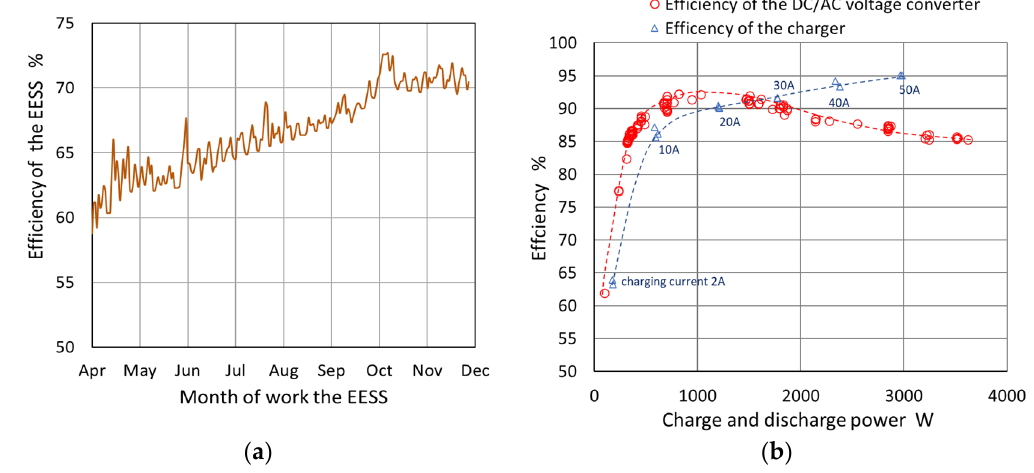
Figure 4. The efficiency of: ( a ) EESS ( b ) charger and DC/AC voltage converter. The visible peaks attribute to cloudy days when the batteries are only discharging.